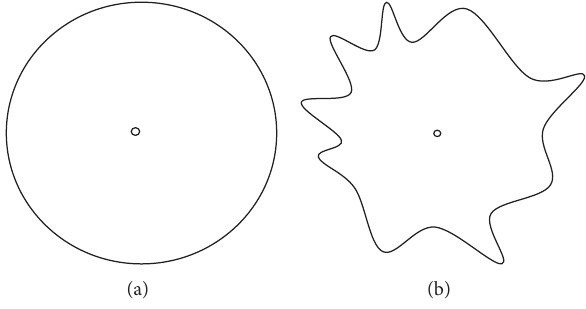
Figure 1: (a) Transmission range in ideal case. (b) Transmission range with impact of path loss and